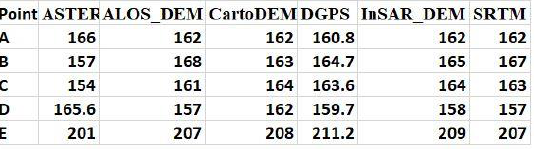
Table-1, Showing height comparison on five different control point in different height